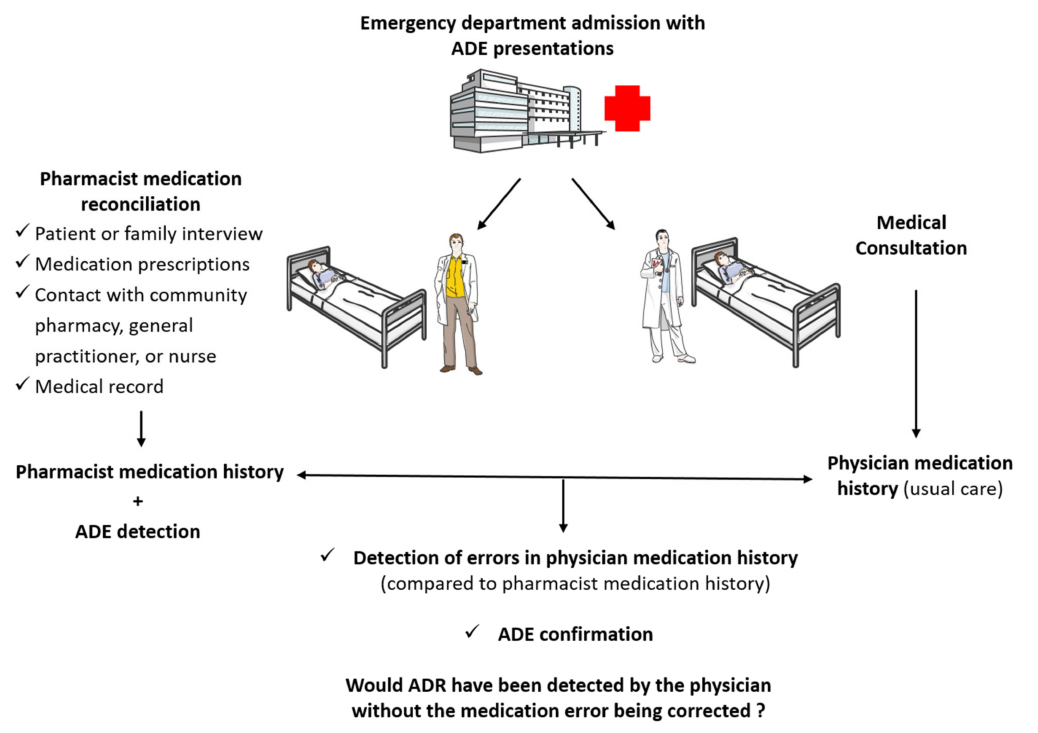
Figure 1. Principle of pharmacist medication history and detection of adverse drug events in the emergency